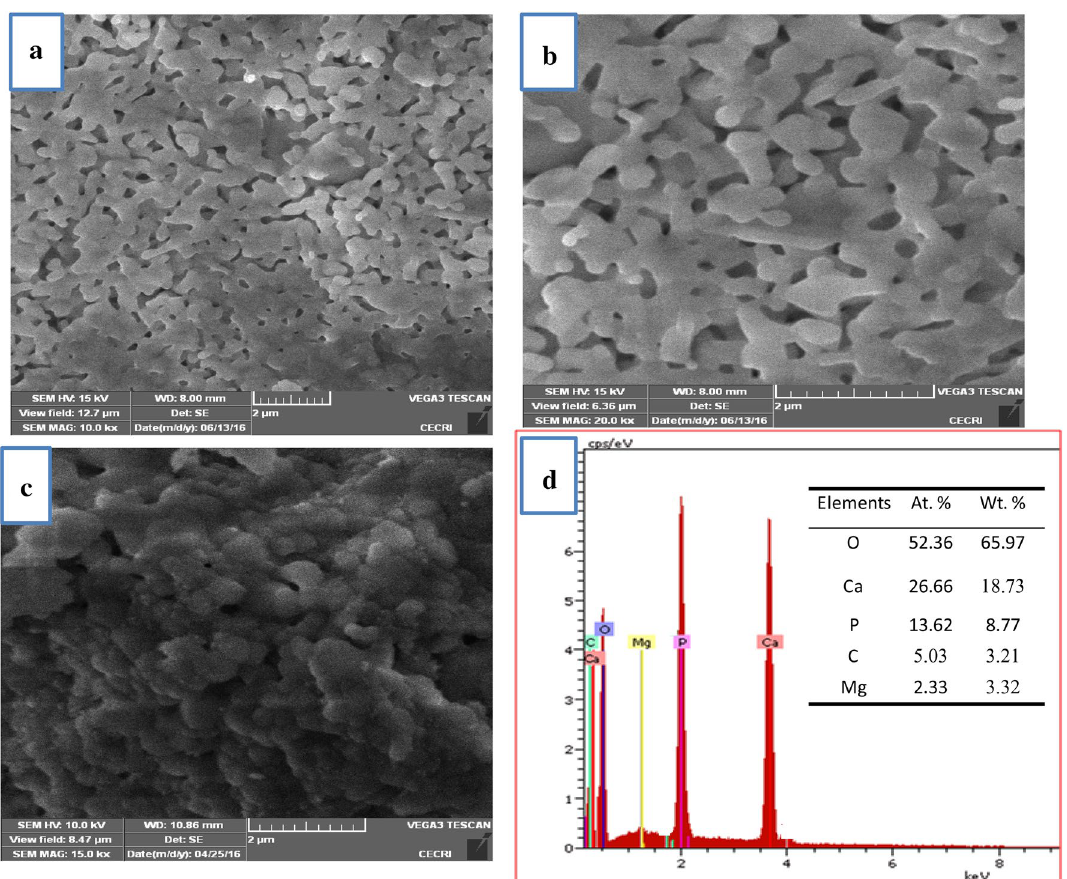
Fig. 9 SEM images of scaffold at a 20%, b 30% and c 0% (control) AMB, d EDX of scaffold